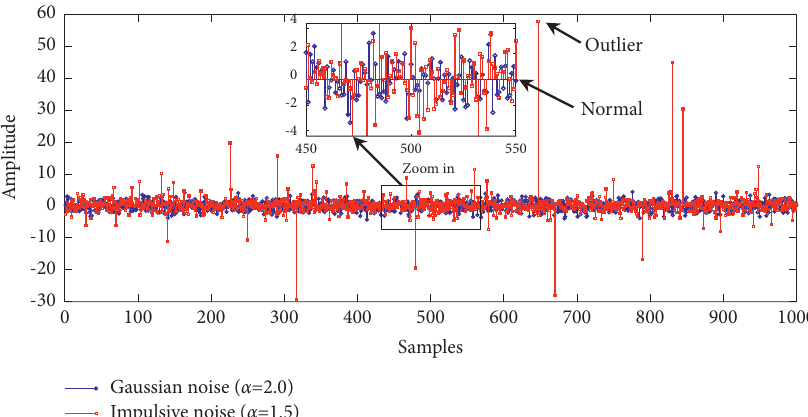
Figure 2: Comparison between Gaussian noise and impulsive